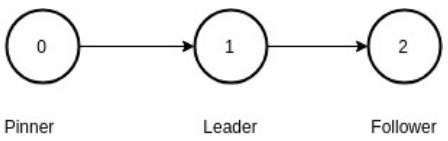
Figure 13. A simple communication graph with path planner, leader and follower.